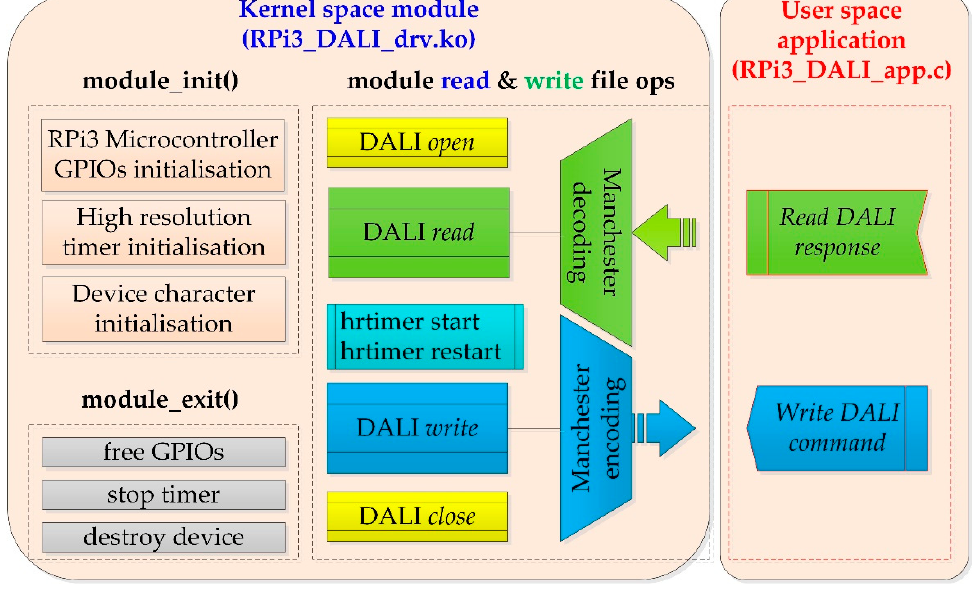
Figure 4. DALI kernel driver module functionality.